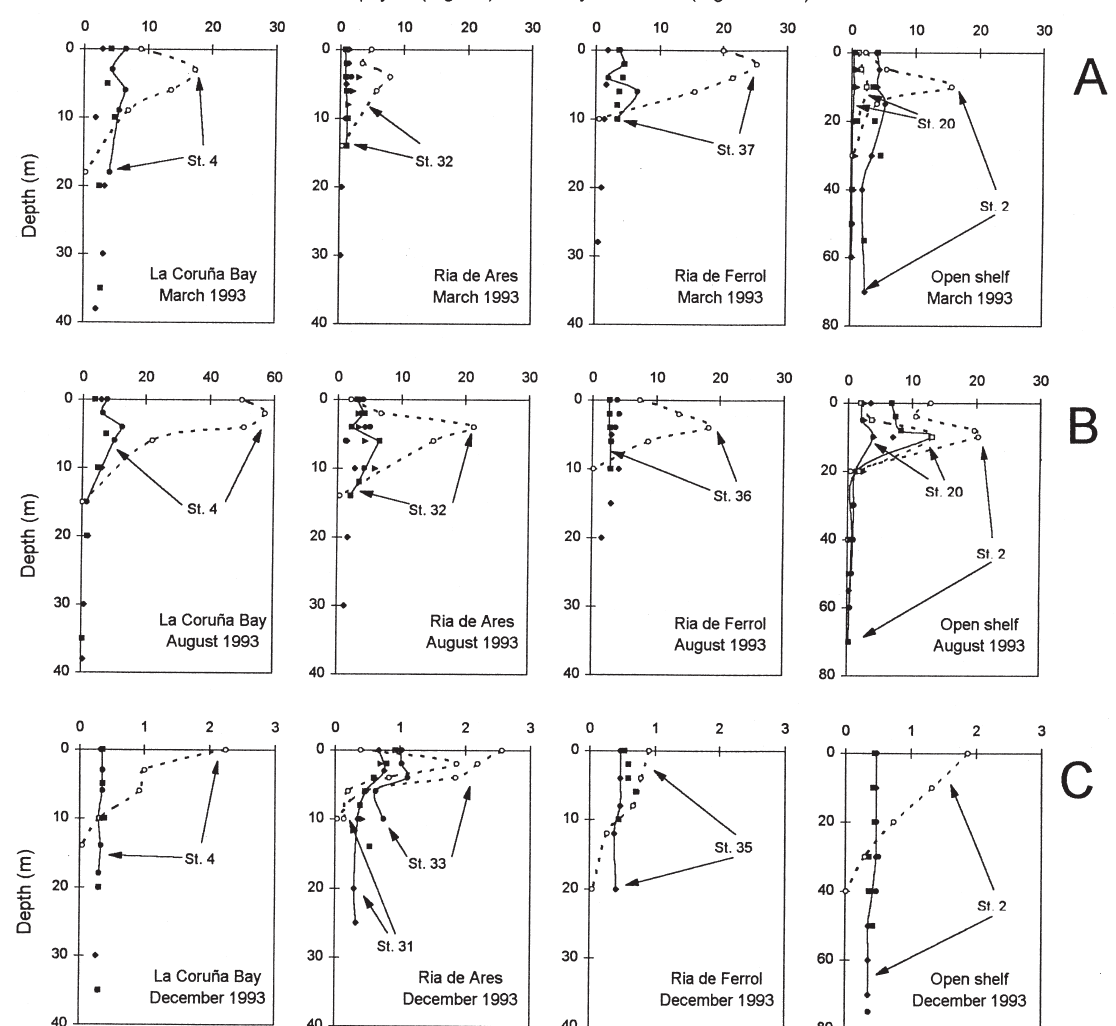
IG . 5. – Vertical profiles of chlorophyll concentration (closed symbols and continuous lines, mg m -3 ) and SIS primary production rates (open symbols and dashed lines, mg C m -2 h -1 ) in four zones during the cruises COPLA-393 (A), COPLA-893 (B) and COPLA-1293 (C). The station number is indicated by